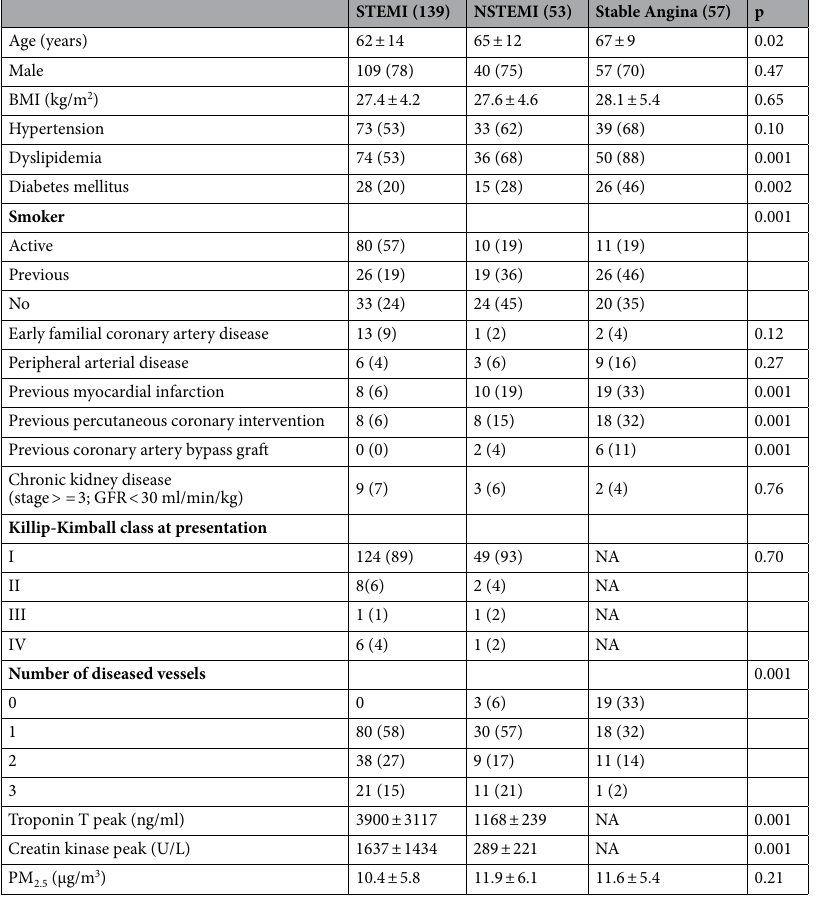
Table 1. Baseline characteristics. Quantitative variables are shown as mean ± SD and qualitative variables are shown as frequency (percentage).